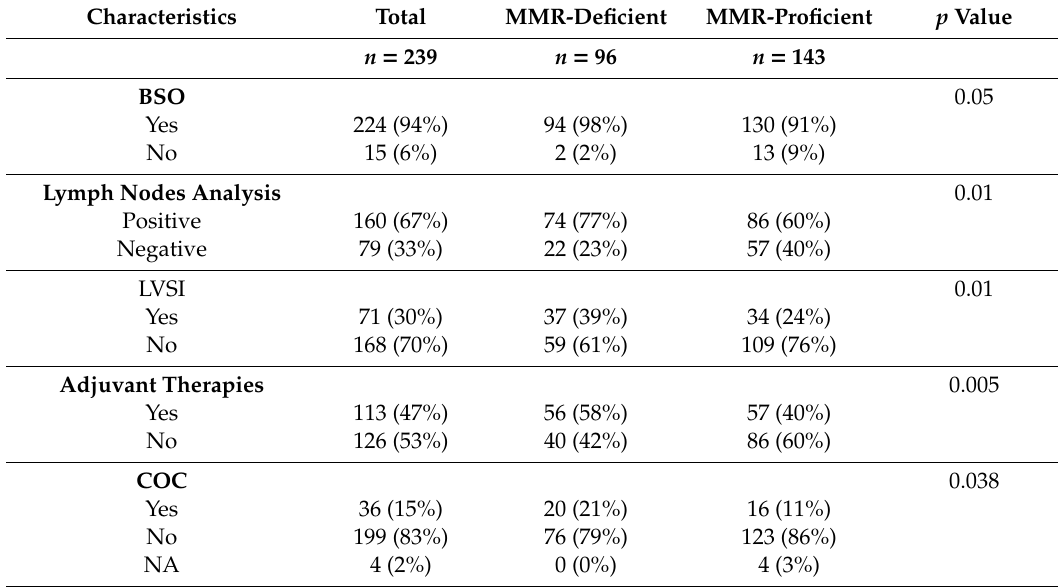
Table 5. Clinical, surgical and pathological differences between MMR-deficient and MMR-proficient Table 5. Clinical,surgicalandpathologicaldifferencesbetweenMMR-deficientandMMR-proficientpatients. patients.